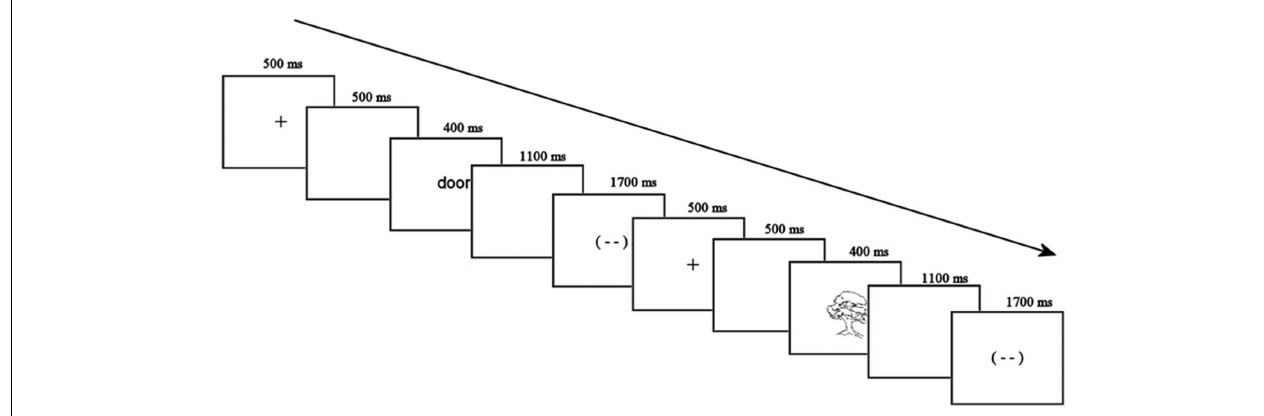
FIGURE 1 |Two sample trials, one with a word stimulus and one with a picture